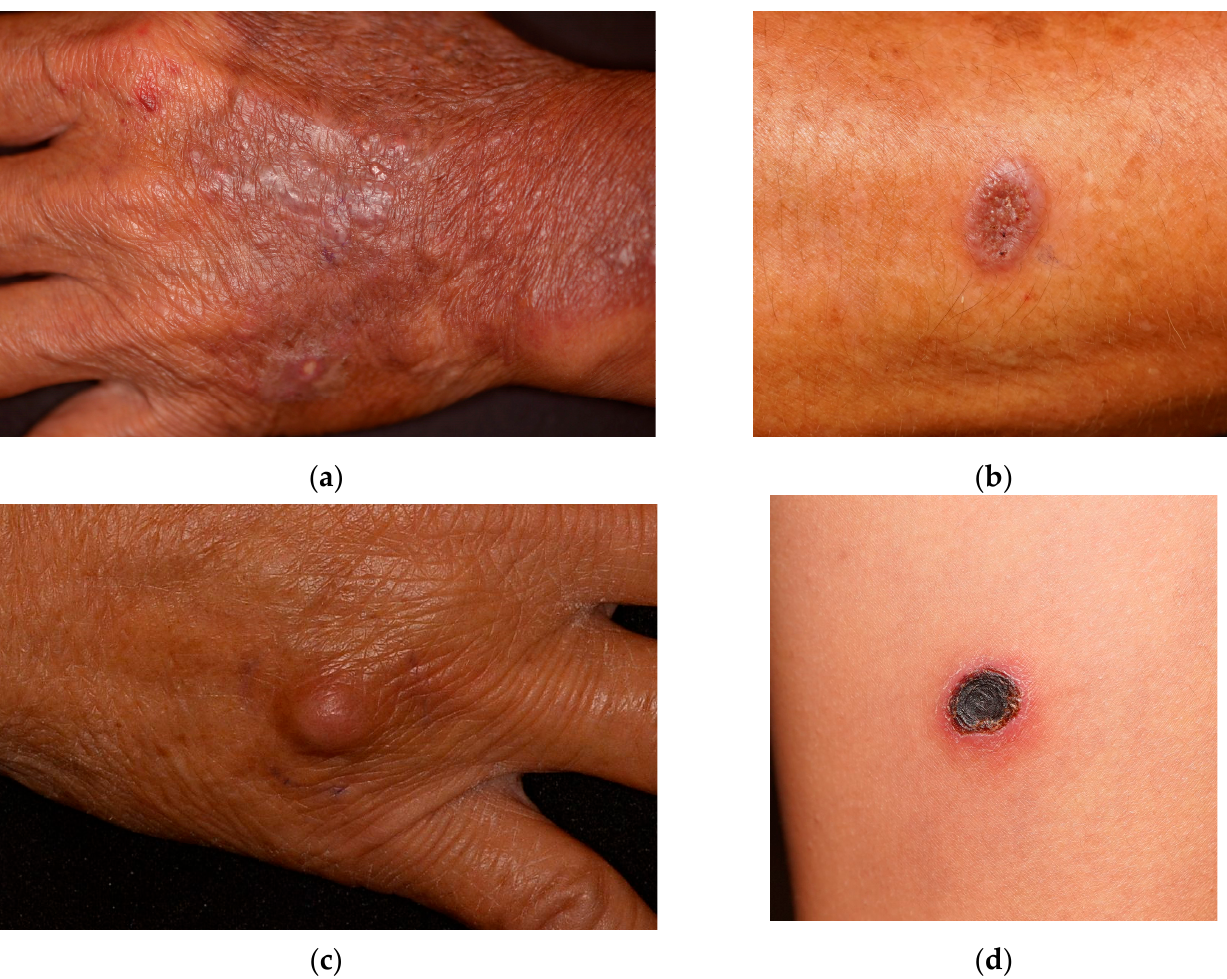
Figure 1. Common appearances of implantation mycoses: ( a ) papuloplaques on the dorsal hand ( Mucor sp.); ( b ) papuloplaque with a verrucous surface ( Nigrospora ); ( c ) nodule on the dorsal hand (unknown pathogen); and ( d ) ulceration on posterior thigh (unknown pathogen).